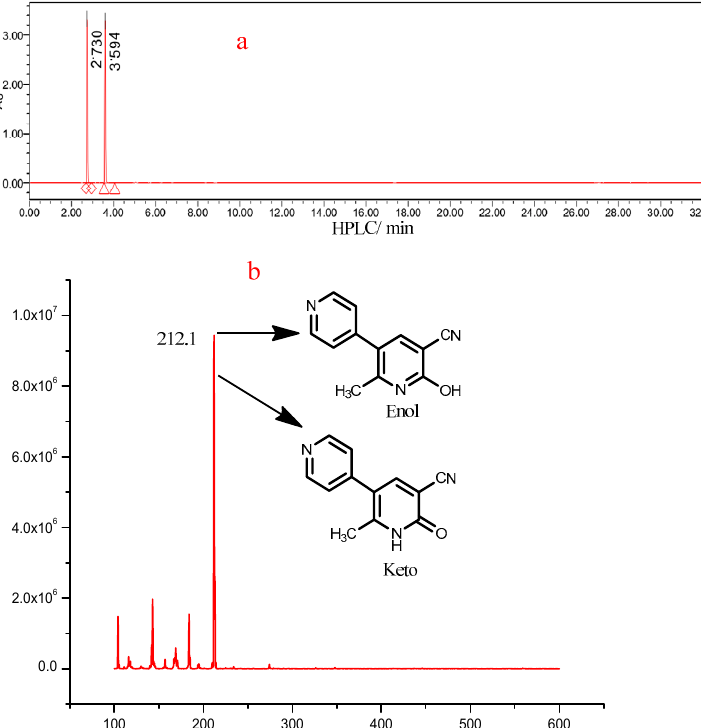
Figure 4. ( a ): HPLC-UV of MLR; ( b ): HRMS of the enol and keto form of MLR.